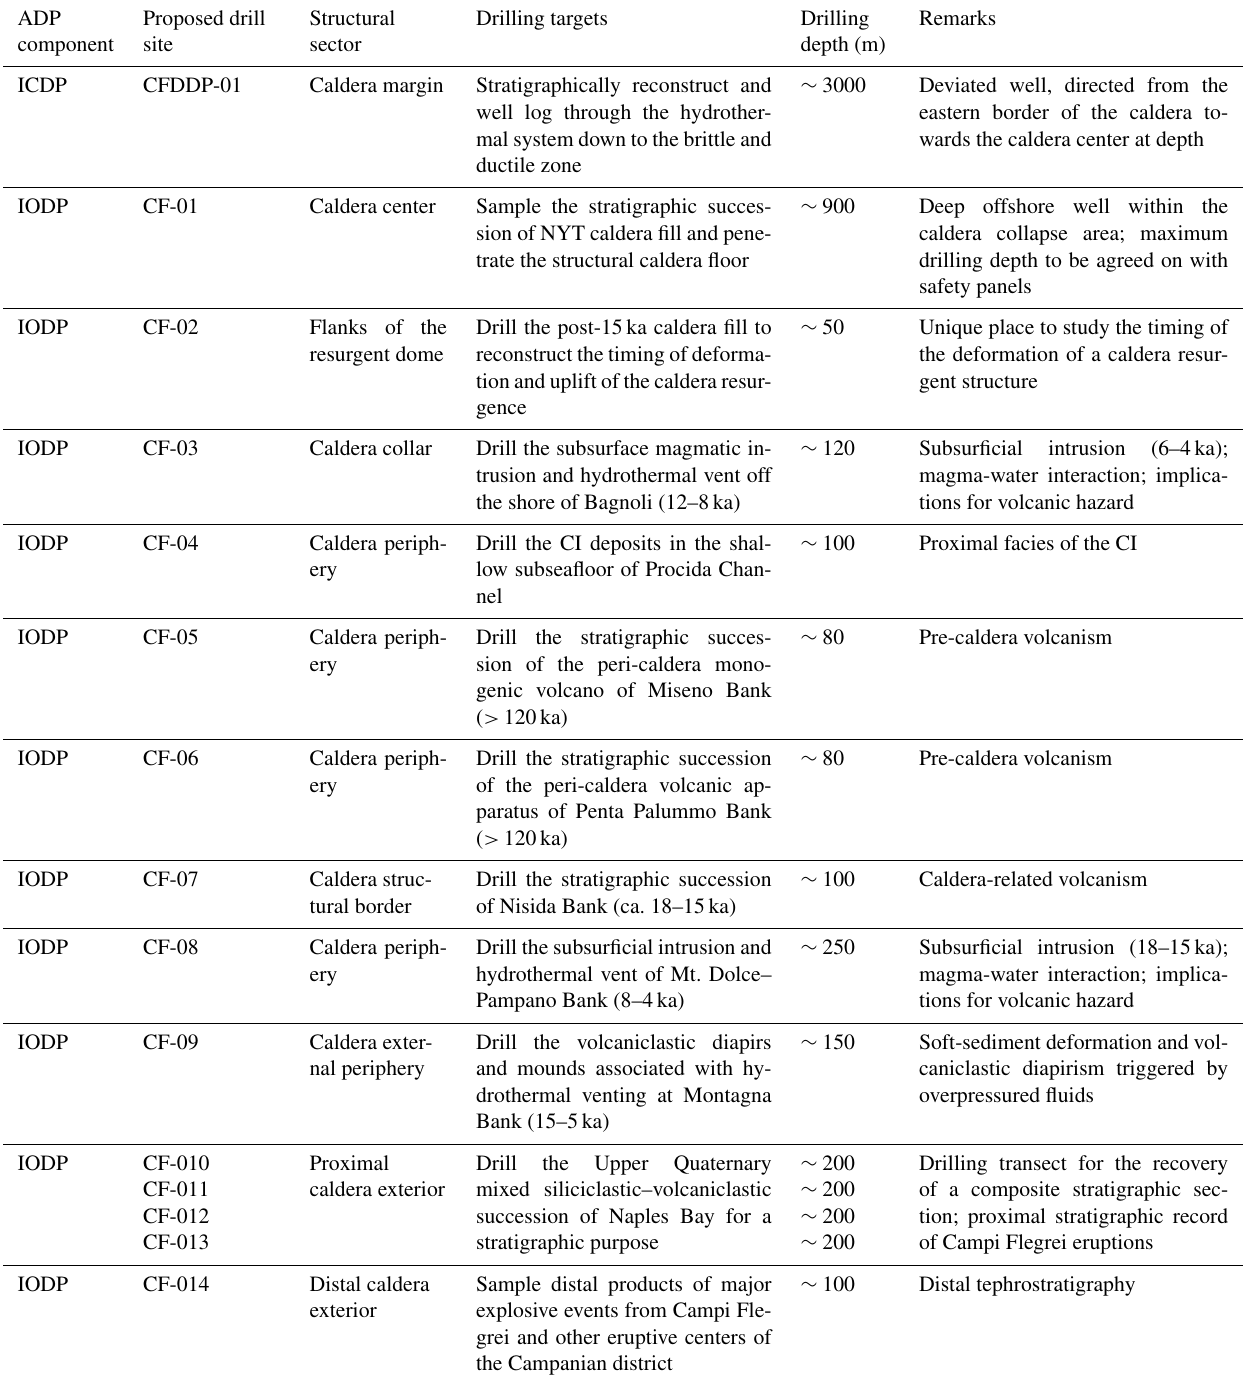
Table 1. Summary of proposed onshore and offshore drill sites for the Campi Flegrei Caldera Amphibious Drilling Proposal (ADP).